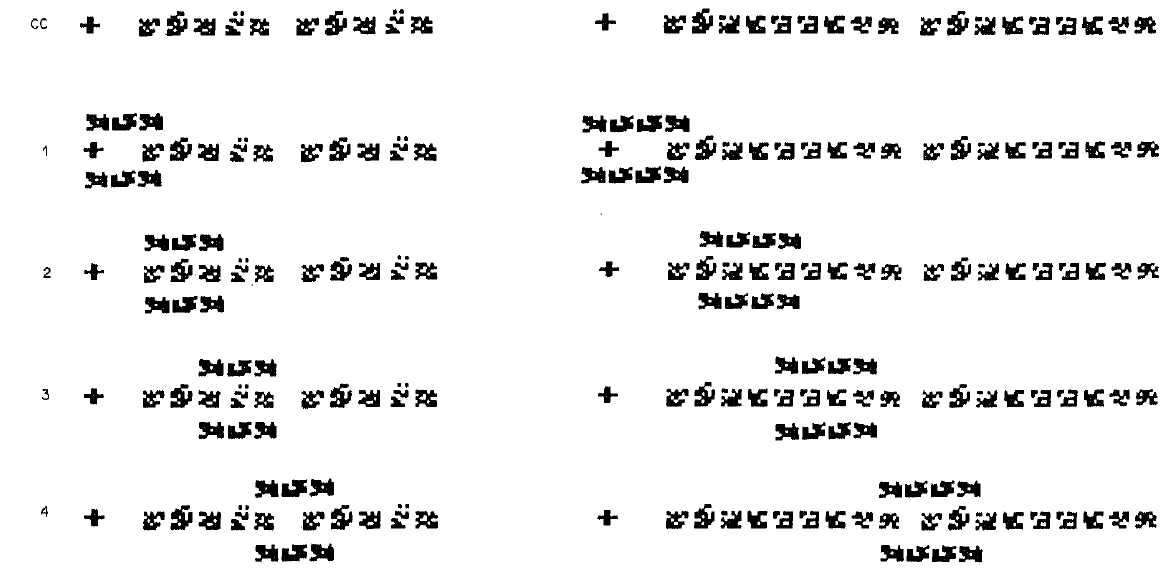
Figure 5. Example stimuli in Vitu’s (1991) Experiment 3. The target stimulus was a word of 5 or 9 letters. This was presented simultaneously with another word to its right (in the illustration, the words were masked in peripheral vision, and they became visible only when a saccade towards the first word was detected) and distractor stimuli (random dots patterns equivalent to masked letters). Distractors were displayed to the left of the beginning or of the centre of the first word, or to the right of the word’s centre or end (Positions 1-4). In a control condition (CC), the two words were displayed with no distractor